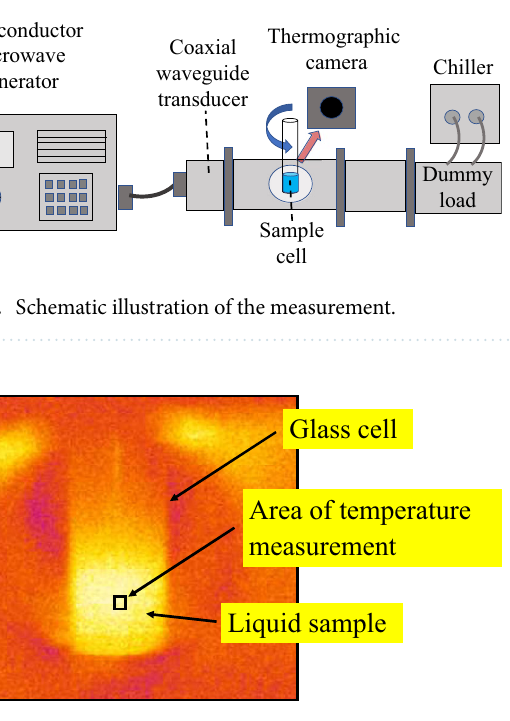
Figure 5. Thermographic image of a liquid-containing glass cell with MW